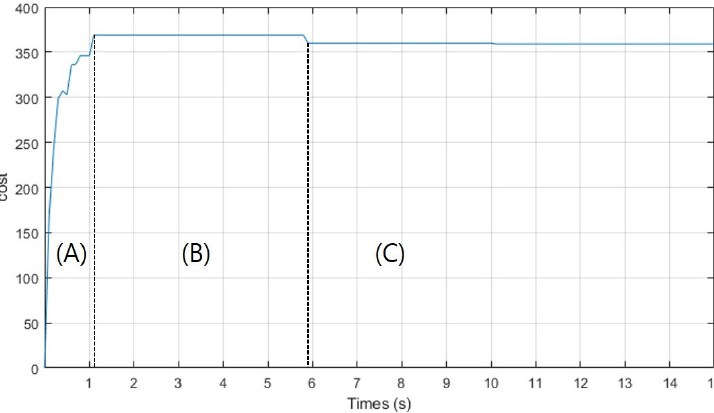
Figure 6. The cost of the solution path by CDT-RRT* in simulation 2.